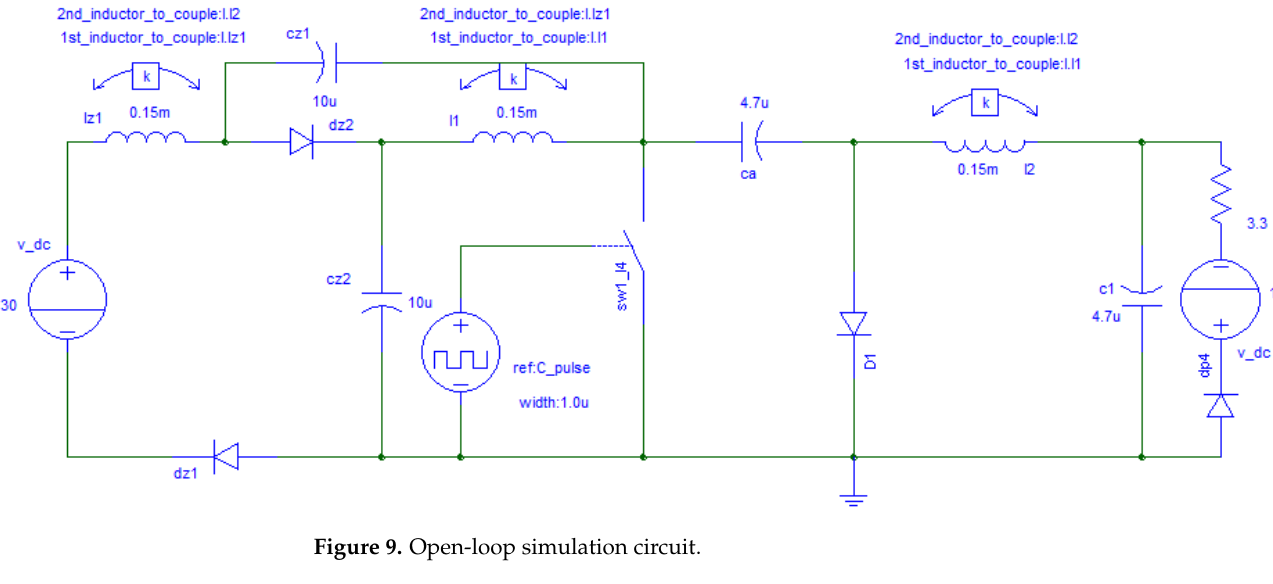
( b ) Figure 11. Photograph of the prototype. ( a ) Front view; ( b ) back view. Table 1. Key parameters of the protype. Parameter